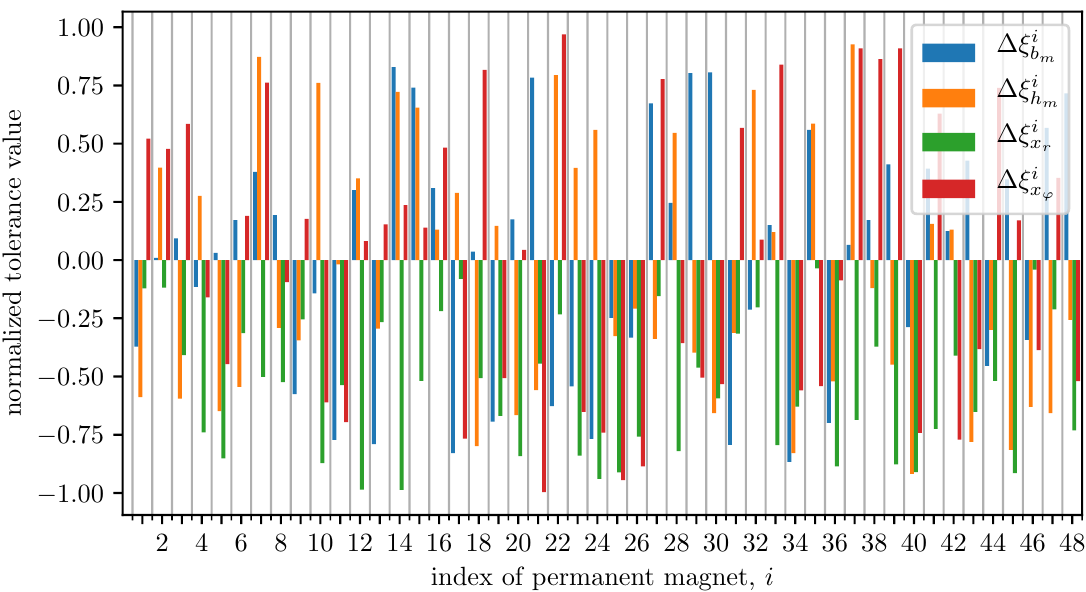
Figure 3. Normalized tolerance values of all 48 permanent magnets for one exemplary sample of the Vernier